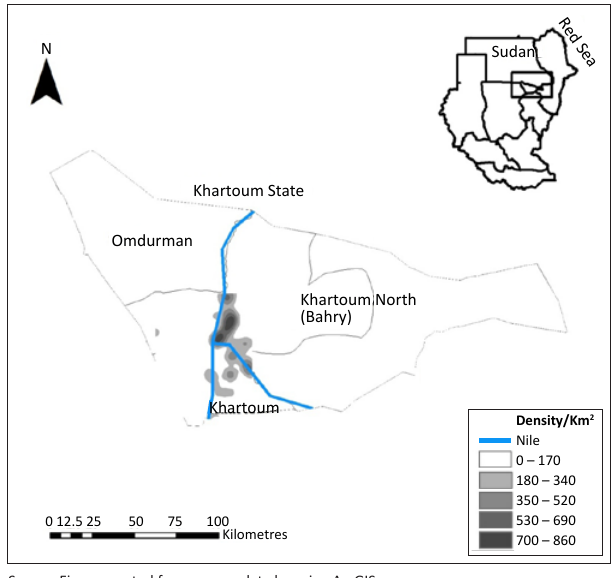
Source : Figure created from census data by using ArcGIS FIGURE 1: Khartoum State map showing the three localities of the study area and the layer farm density in the State for 2007/2008.